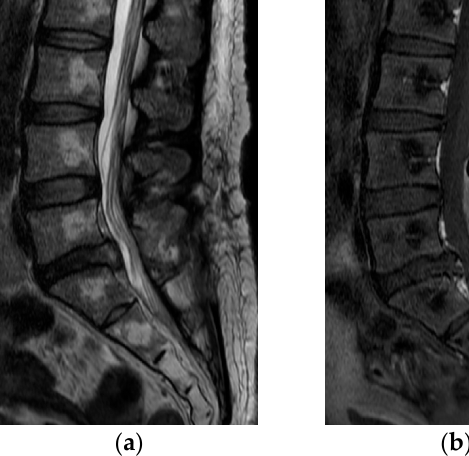
Figure 2. Magnetic resonance imaging (MRI) was conducted to assess the recurrent pain in her back and left lower extremity at 11 days after surgery. ( a ) MRI revealed no evidence of recurred or remnant disc. ( b , c ) However, diffuse enhancement was noted at the posterior epidural space from L4 to S1 levels (arrows) and around the peridural space at the L5/S1 level (arrows).